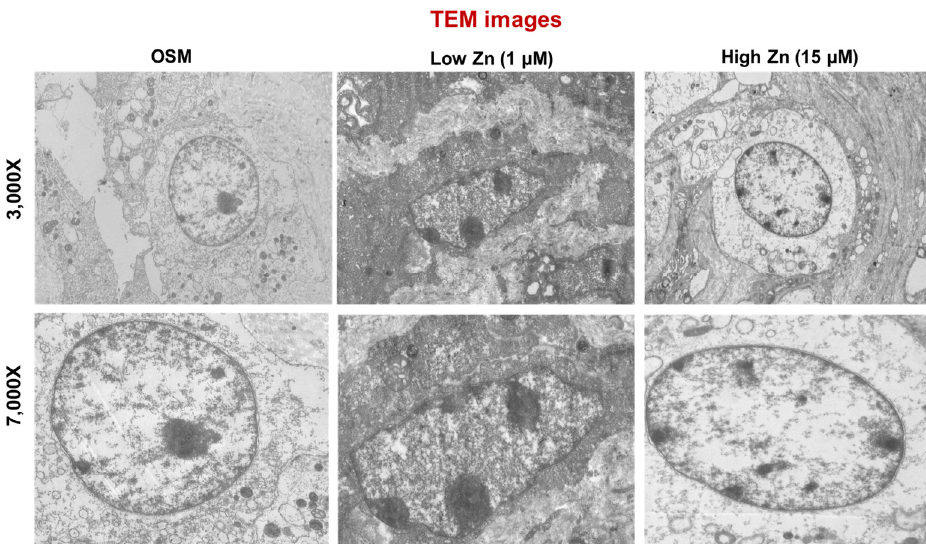
Figure 5. Apoptotic effects of Zn deficiency in MC3T3-E1 cells. OSM is the normal osteogenic differentiation medium without Zn chelator, TPEN. 1 μ M (low Zn) and 15 μ M (high Zn) are the media Zn added as designated with TPEN. Representative transmission electron microcopy (TEM) images (3000Xor 7000X) of MC3T3-E1 cells ( n = 5) treated with either low or high Zn were visualized. The normal OSM serves as controls.